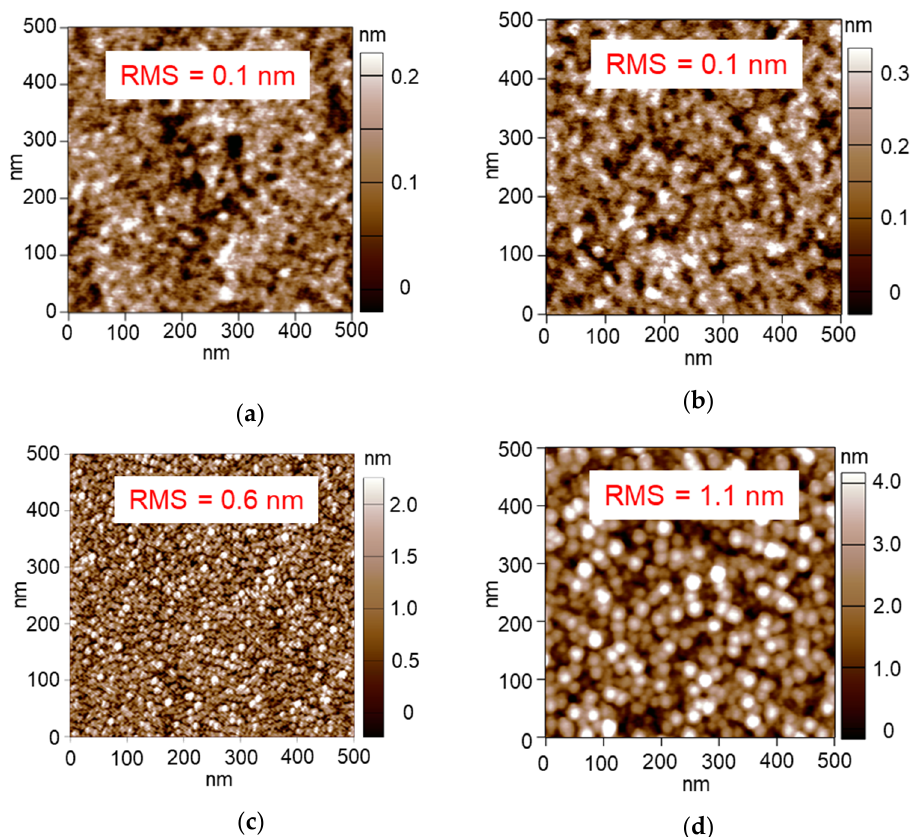
Figure 7. AFM images of the 20–180 s sputtered and 300 ◦ C-calcined Pt / Al 2 O 3 substrates. ( a ) 20 s, ( b ) 40 s, ( c ) 90 s and ( d ) 180 s.